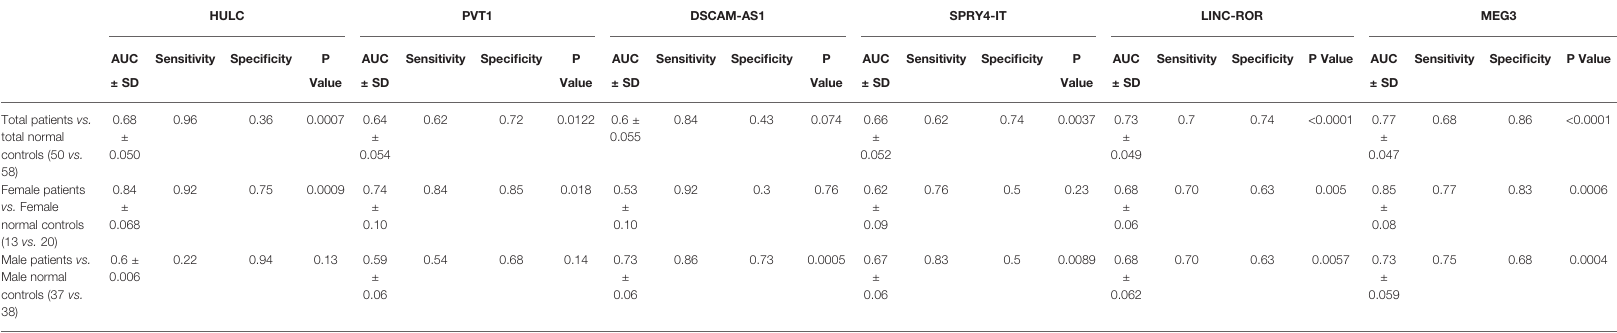
TABLE 4 | Sensitivity, speci fi city and AUC values of each lncRNA in separation of PD cases from controls. HULC